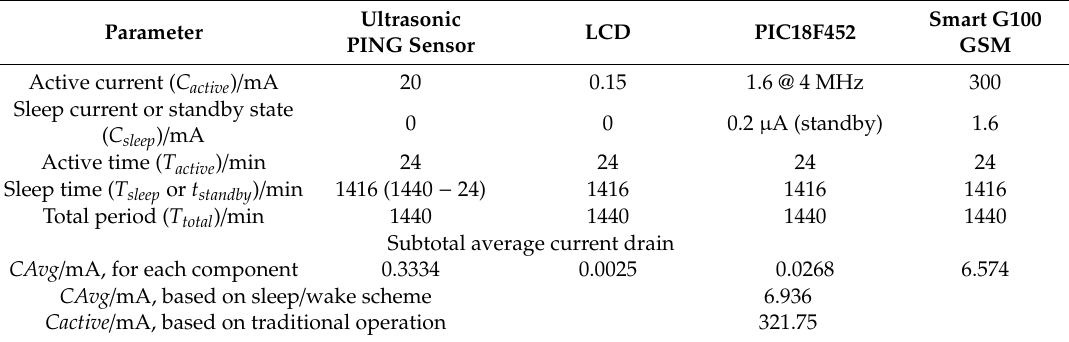
Table 2. Current consumption profile for each component of the proposed monitoring